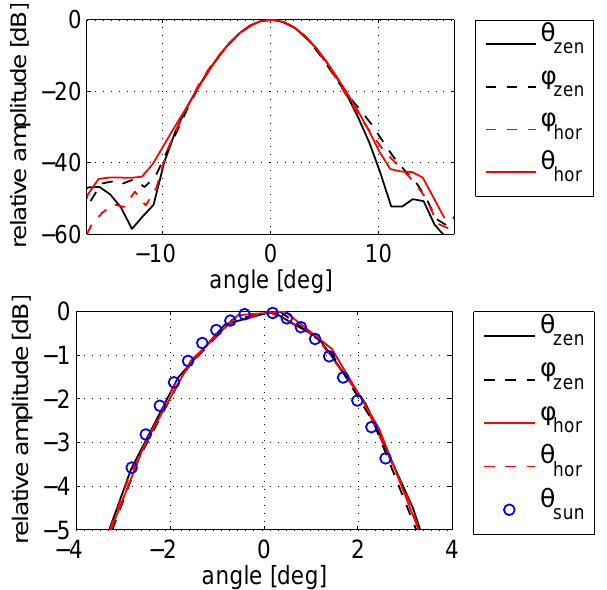
Fig. 4. Farfield at 22.235GHz of the optical system of MIAWARA-C measured with two different methods. Laboratory measurements deliver the farfield pattern in scanning direction θ and the direction φ orthogonal to the scanning plane for the zenith and the horizon. The measurement using the Sun as radiation source results in a pattern in scanning direction at the elevation angle of the